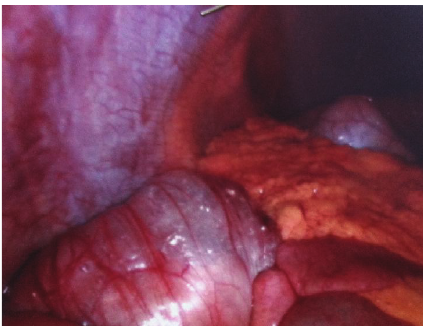
Figure 1: Figure shows the anterior abdominal wall above with pneumatosis intestinalis on the ascending colon with omentum and small bowel loops medially.